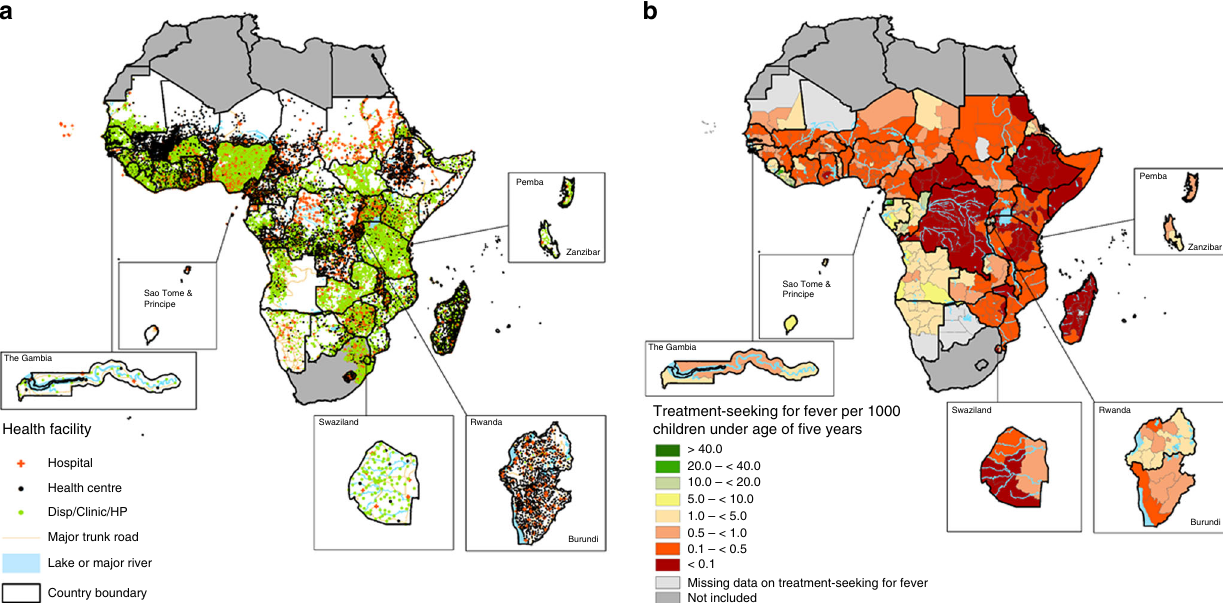
Missing data on treatment-seeking for fever Not Fig. 1 Health facilities and cases of fever. a The distribution of public health facilities in sub-Saharan Africa by type. b Aggregate estimates of cases of fever treated at Administrative level 1 per 1000 children under fi ve (weighted by the population at risk). Overall, 56,719 out of 99,631 sampled children sought fever treatment in the public sector. Data assemblies were between 2010 – 2016, except for South Sudan and Djibouti. Northern Africa countries and South Africa were not included in the analysis. Data were obtained from national reports in countries where georeferenced data were not available, for